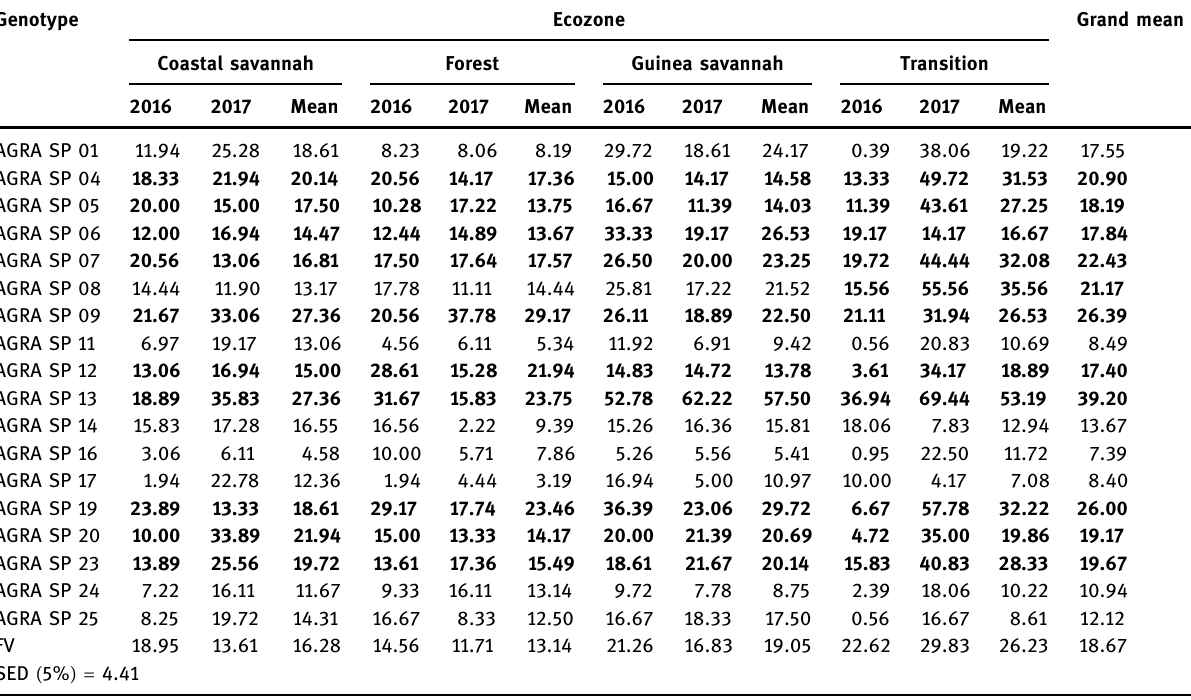
Table 4: Storage root yield ( t/ha ) of the sweetpotato genotypes across ecozones over two years